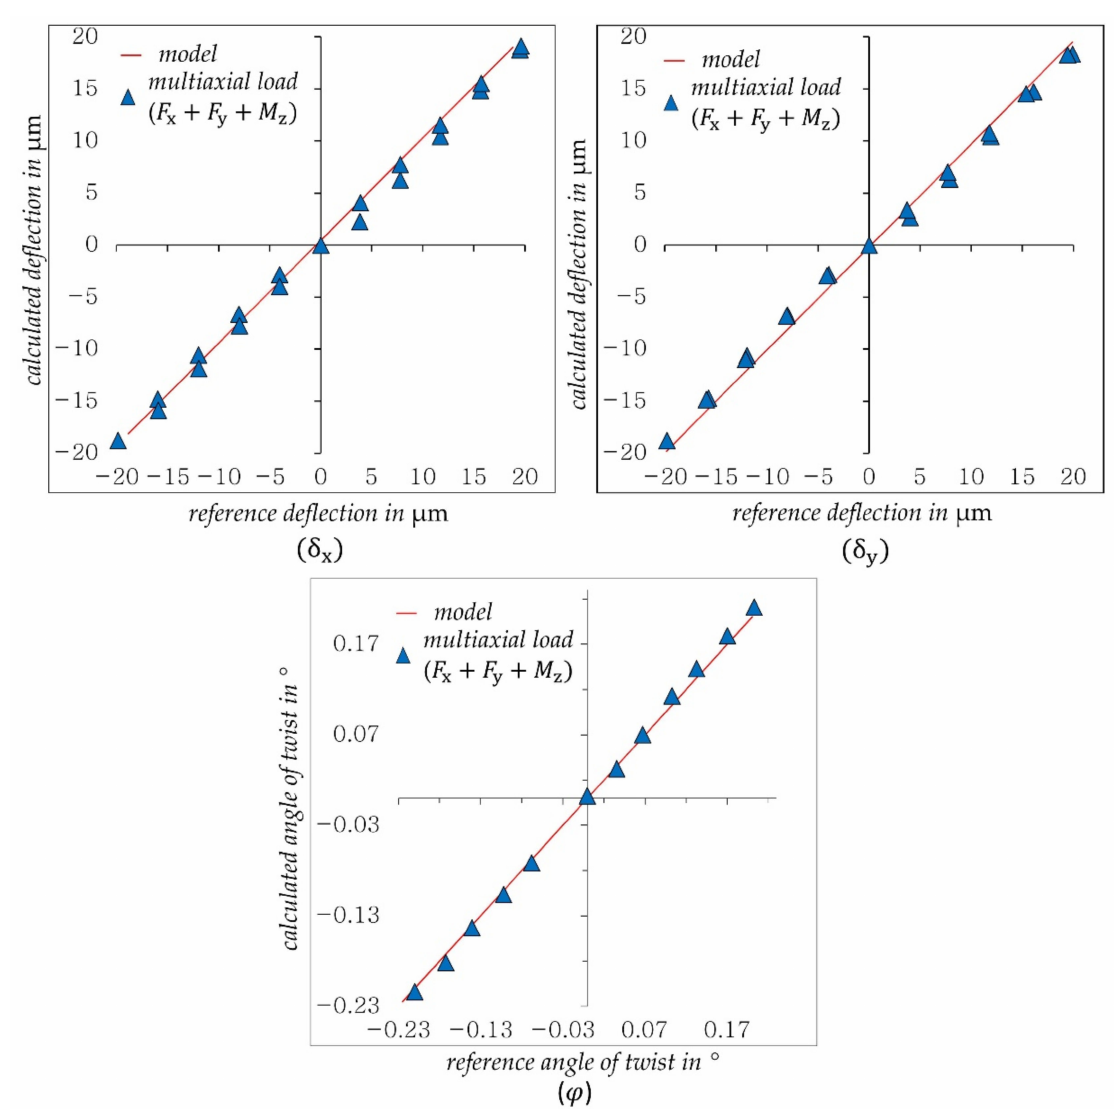
Figure 11. Calculated displacement components ( δ x , δ y , ϕ ) when multiaxial loading the structure with ( F x + F y + M z ). The calculated deflections δ x , δ y and the twist angle ϕ also show good and linear agreement with the reference values. Compared to uniaxial loads in Figure 7, a